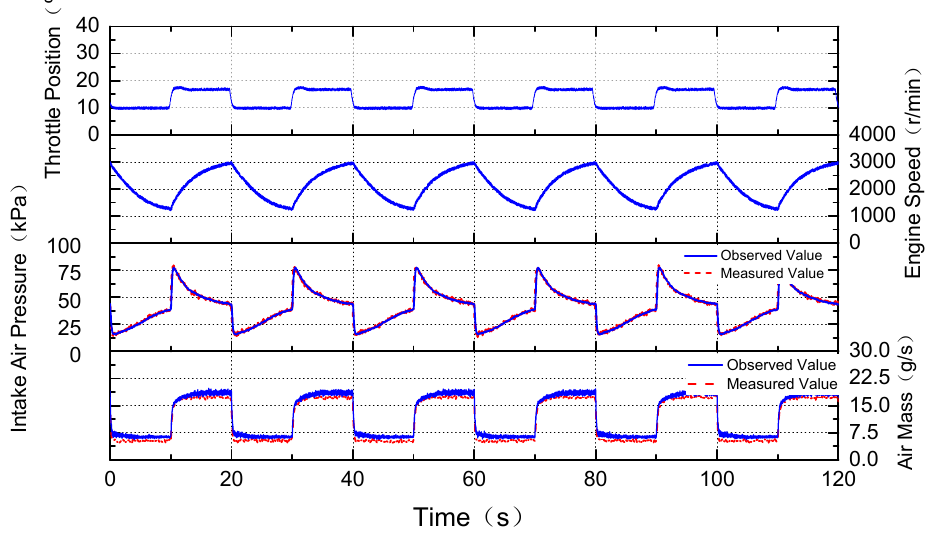
Figure 9. Experimental results of the intake air mass observation.